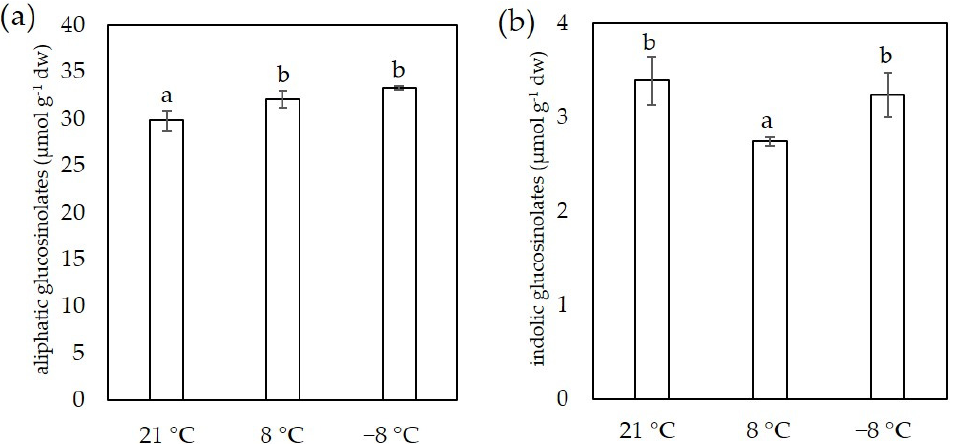
Figure 5 . The content of aliphatic and indolic glucosinolates in flat leafe kale sprouts ( B. oleracea var. acephala ) affected by different temperatures measured by spectrophotometry ( a ) and HPLC-DAD ( b ) method. Value marked with different letters are significantly different at p < 0.05.